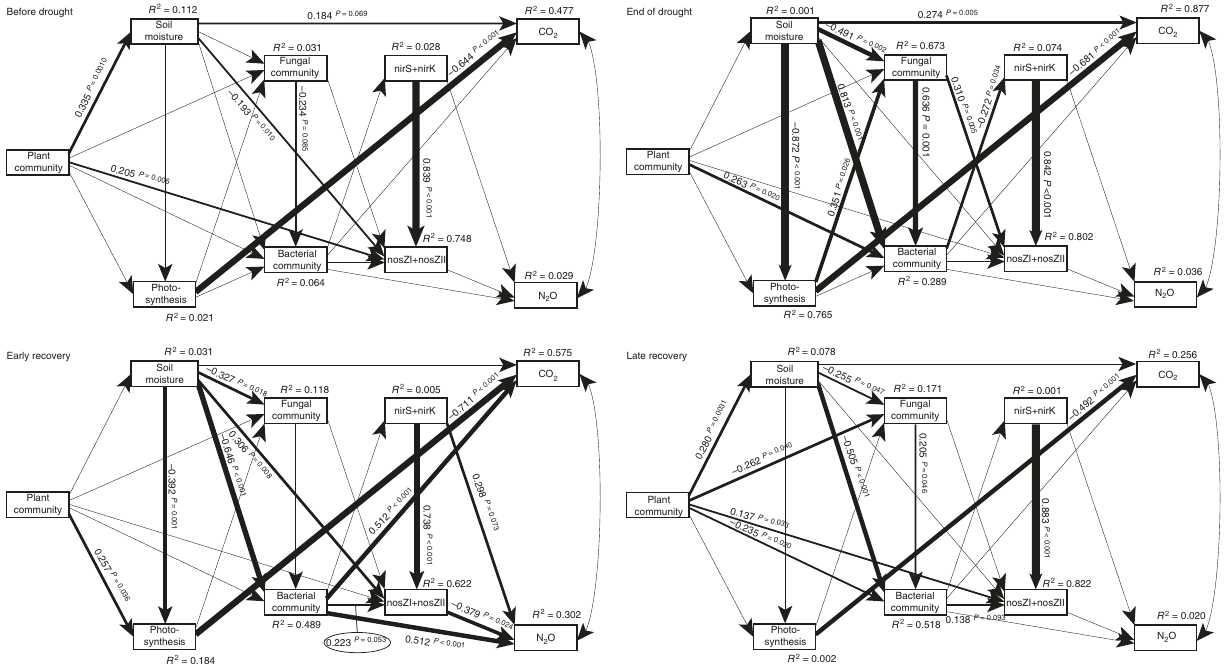
Fig. 9 Structural equation model of relationships between plant community attributes, microbial properties and ecosystem functioning for each sampling. For each signi fi cant relationship, standardised coef fi cient and P = values are given alongside arrow, and arrow weights are proportional to standardised coef fi cients. Our multigroup model fi t the data well: P = 0.309, CFI = 0.994, P RMSEA < = 0.05 =